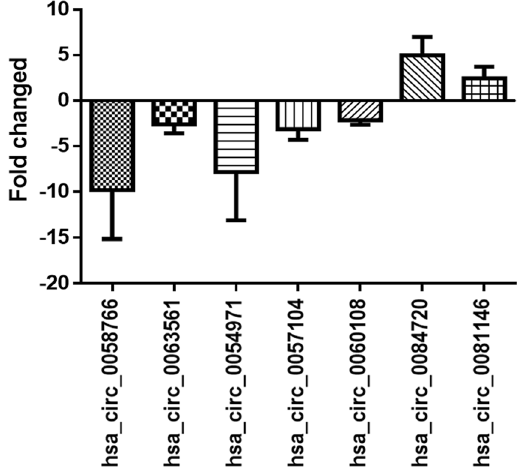
Figure 2. Verification of the differentially expressed circRNAs by qRT-PCR. The expression of 7 lncRNAs in 50 paired GC tissues was detected by qRT-PCR, which were shown by the expression fold changes. Comparison of the results obtained from qPCR and microarray assay revealed satisfactory consistency.